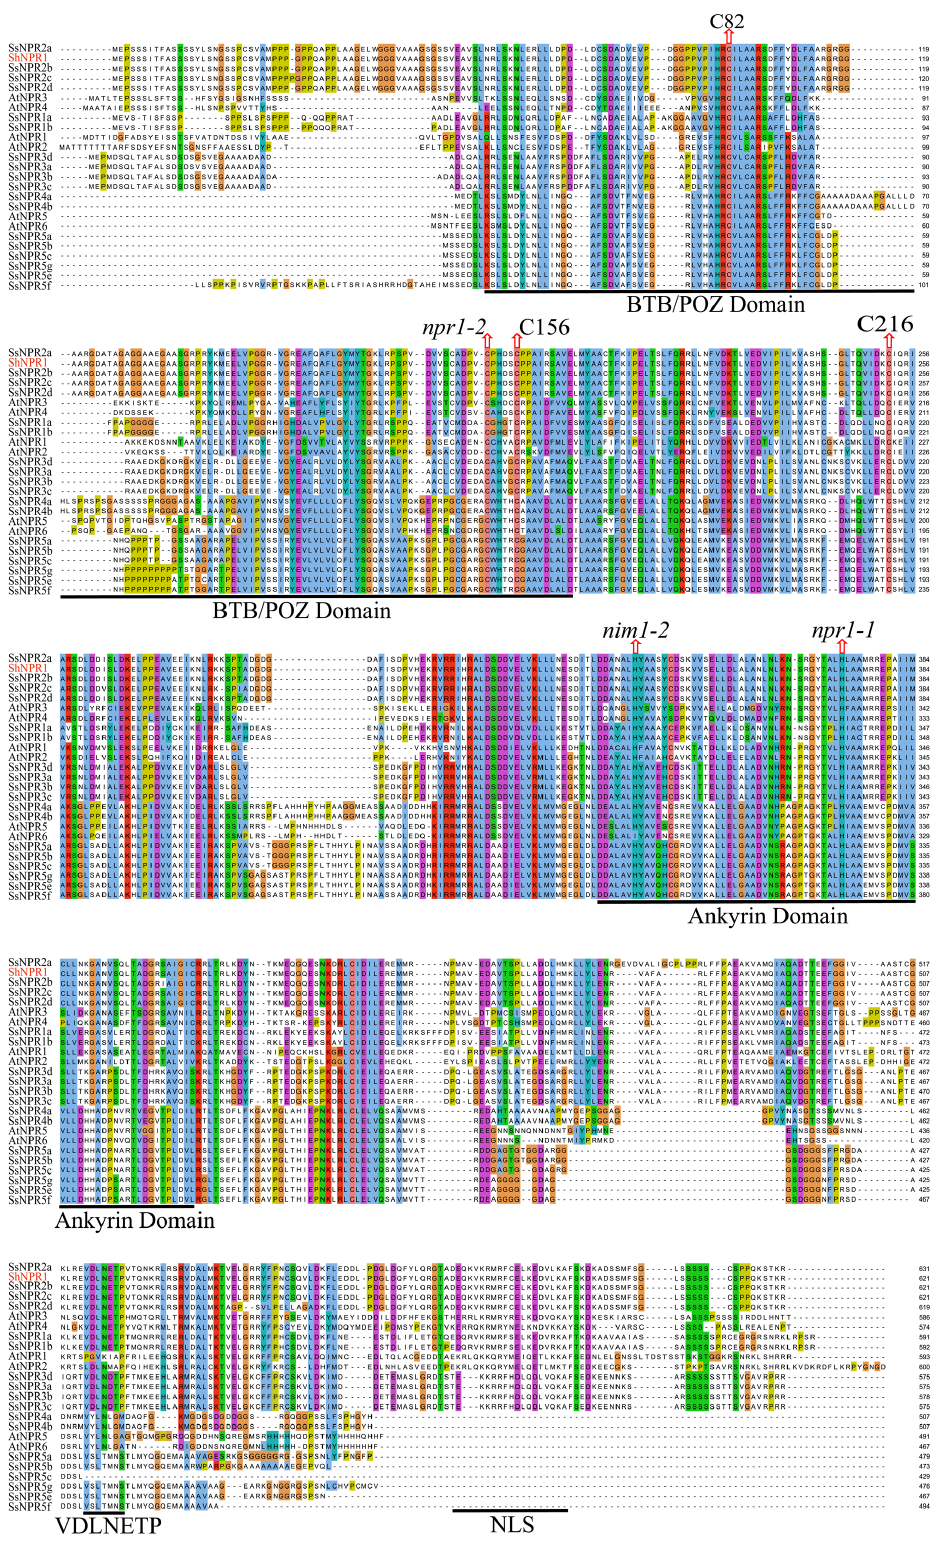
Figure 6. Multiple alignments of amino acid sequences of NPR1-like proteins in Saccharum and Arabidopsis thaliana . BTB/POZ, ankyrin conserved domains, EAR-like repression motif (VDLNETP), and nuclear localization signal (NLS) are underlined in black. npr1-1, npr1-2, and nim1-2 in AtNPR1 mutation sites, and the highly conserved cysteines residues (C82, C216, and C156) in AtNPR1 are shown by red